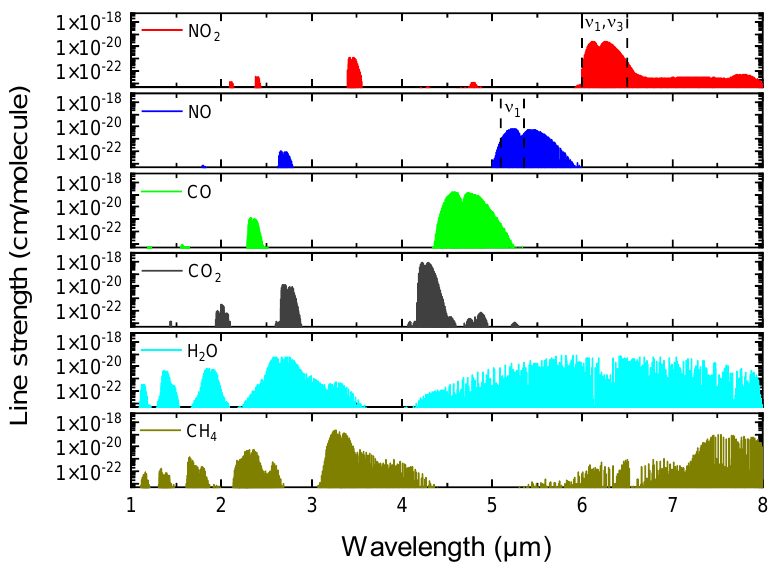
Figure 1. Absorption line strength for near- and mid-infrared bands of typical combustion exhaust at 600 K based on HITRAN 2020 [40] . Transitions with a line strength of less than 5 × 10 -24 cm/mol- ecule are not shown.